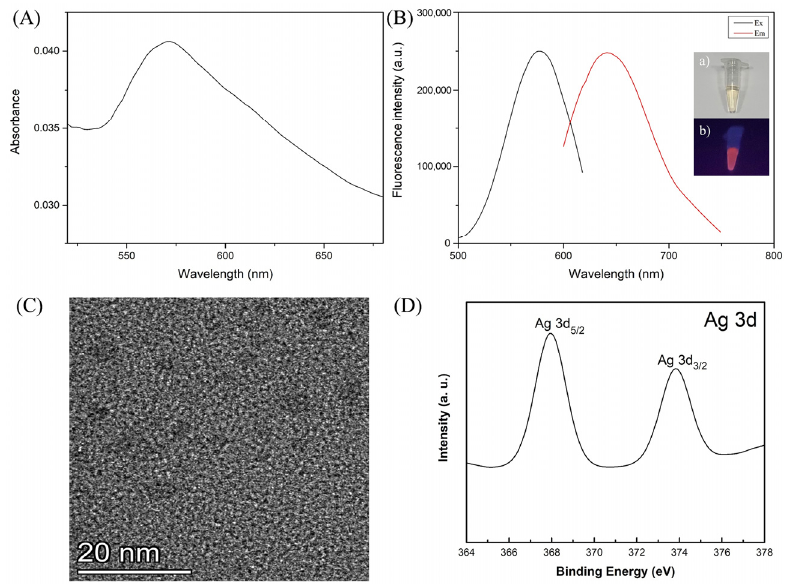
Figure 2. Synthesis of DNA-AgNCs characterization. ( A ) UV − vis absorption spectra of DNA-AgNCs. ( B ) Excitation and emission spectra of DNA-AgNCs. Inset: photograph under the room light (a) and UV light (b). ( C ) TEM image of DNA-AgNCs (Scale bar: 20 nm). ( D ) X-ray photoelec-